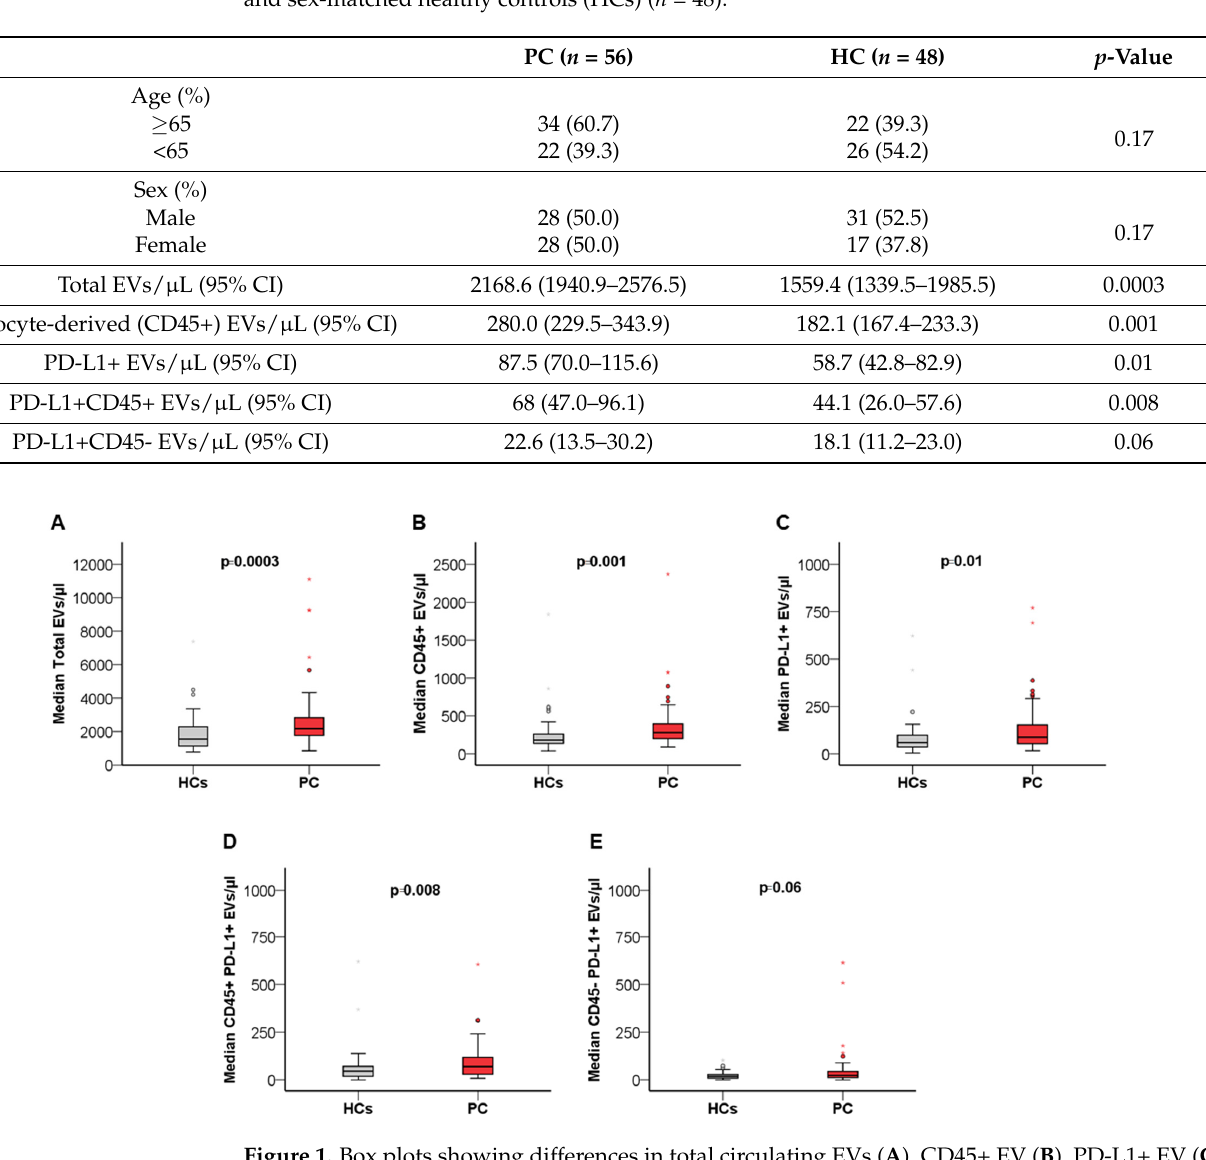
Table 3. Comparison of total and subtype EV concentrations between PC patients ( n = 56) and age and sex-matched healthy controls (HCs) ( n = 48).